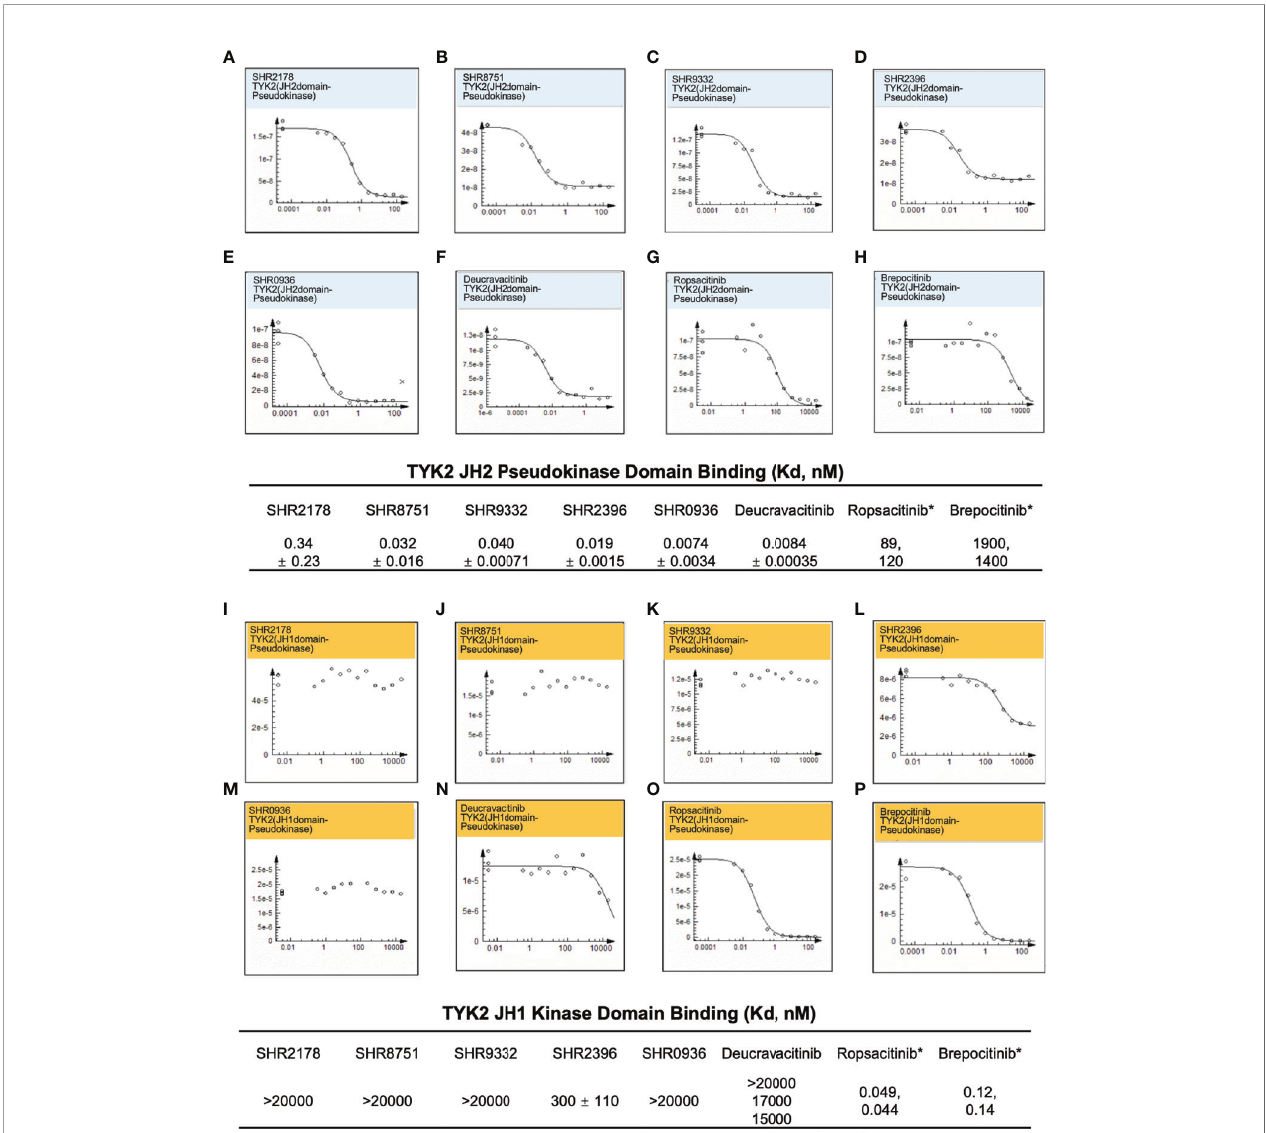
FIGURE 2 | Small molecule TYK2 pseudokinase ligands showed high af fi nity-binding for TYK2 JH2 pseudokinase domain and low af fi nity for isolated TYK2 JH1 kinase domain. (A – F) Binding af fi nity of TYK2 and JAK compounds to TYK2 JH2 pseudokinase domain in KdELECT Competition Binding Assay (DiscoverX). Representative dose-response curves of: (A) SHR2178; (B) SHR8751; (C) SHR9332; (D) SHR2396; (E) SHR0936; (F) Deucravacitinib; (G) Ropsacitinib; (H) Brepocitinib. Dissociation constants (Kds) for test compound-TYK2 JH2 interactions are calculated by measuring the amount of isolated TYK2 JH2 pseudokinase captured on the solid support as function of the test compound concentrations; (I-P) Binding af fi nity of TYK2 and JAK compounds to TYK2 JH1 catalytic domain in DiscoverX KdELECT Competition Binding Assay. Representative dose-response curves of: (I) SHR2178; (J) SHR8751; (K) SHR9332; (L) SHR2396; (M) SHR0936; (N) Deucravacitinib; (O) Ropsacitinib; (P) Brepocitinib. Dissociation constants (Kds) for test compound-TYK2 JH1 interactions are calculated by measuring the amount of isolated TYK2 JH1 kinase captured on the solid support as function of the test compound concentrations. Con fi rmatory studies were performed for the compounds. The fi gures are representative of